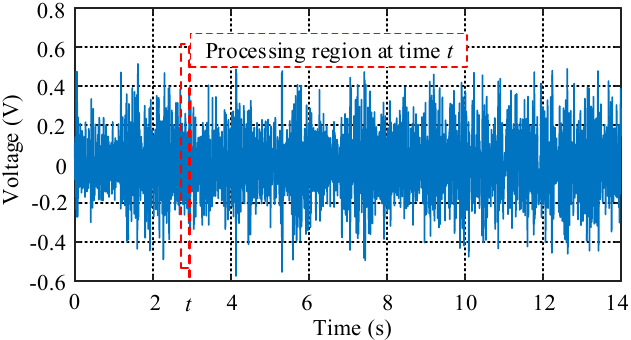
Figure 3. The AE signal during bone drilling in time domain, part of the signal in the dashed frame is used for subsequent signal processing of time t .